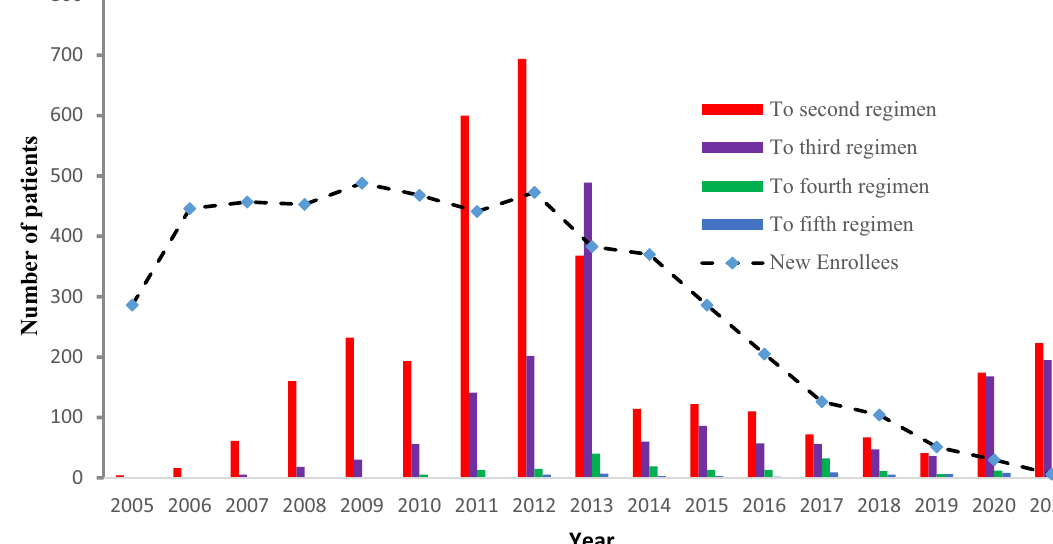
Figure 2. Continuous field information on enrollment and modification